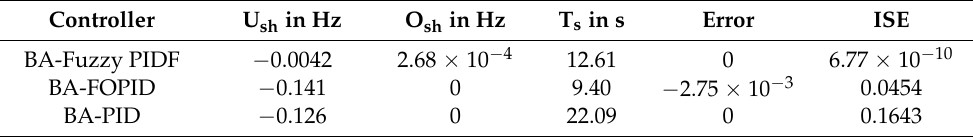
Figure 14. Comparison of three controllers tuned by BA based on ITAE for scenario 2. Table 15. Frequency response performances with different BA-tuned controllers designed via ISE for scenario